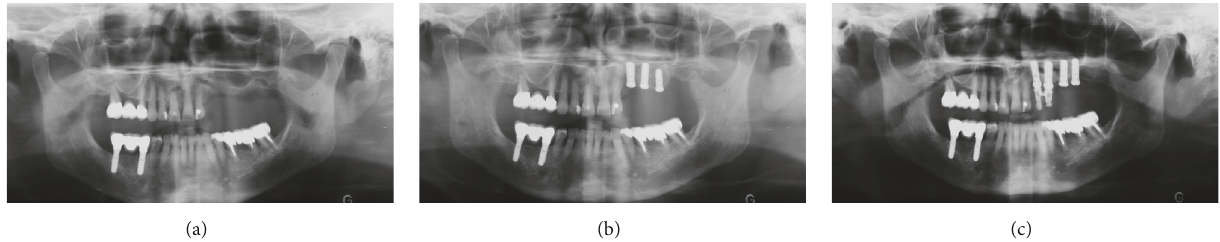
Figure 1: Placement of implants, panoramic radiographs. (a) Initial situation, (b) immediately after implant placement in sites 23, 24, and 25, and (c) 7 months later, immediately after implant placement in sites 25 and 26.